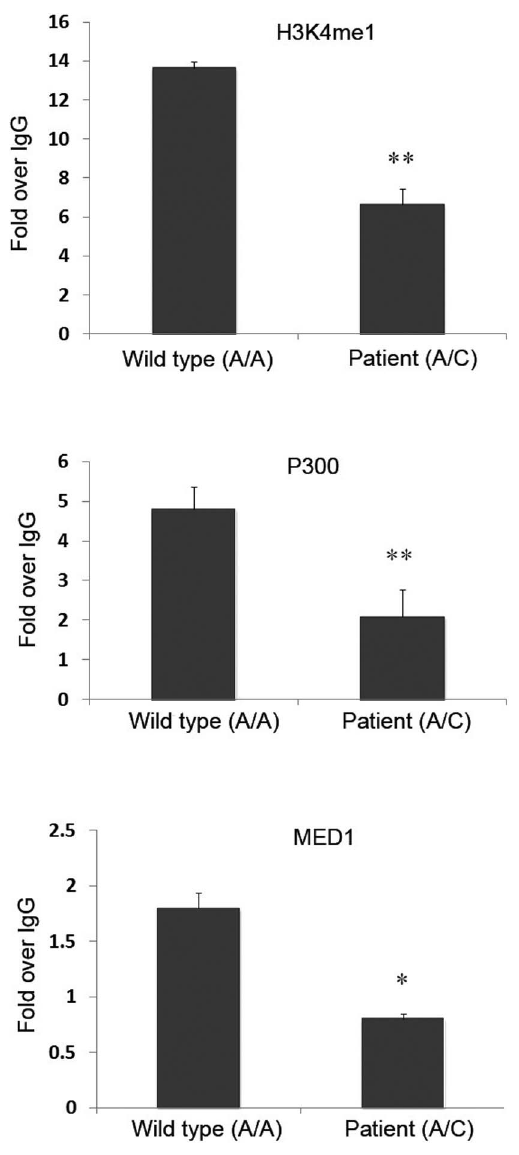
Figure 3. The 4q32A . C mutation is associated with reduced levels of enhancer markers. ChIP assays of lymphoblastoid cell lines established from a control individual (4q32-A/A) and a PTC patient in the family (4q32-A/C). Antibodies against H3K4me1, P300, and MED1 were used in the assays. **: p-value , 0.01; *: p-value , 0.05. Error bars represent 6 SD of at least three independent